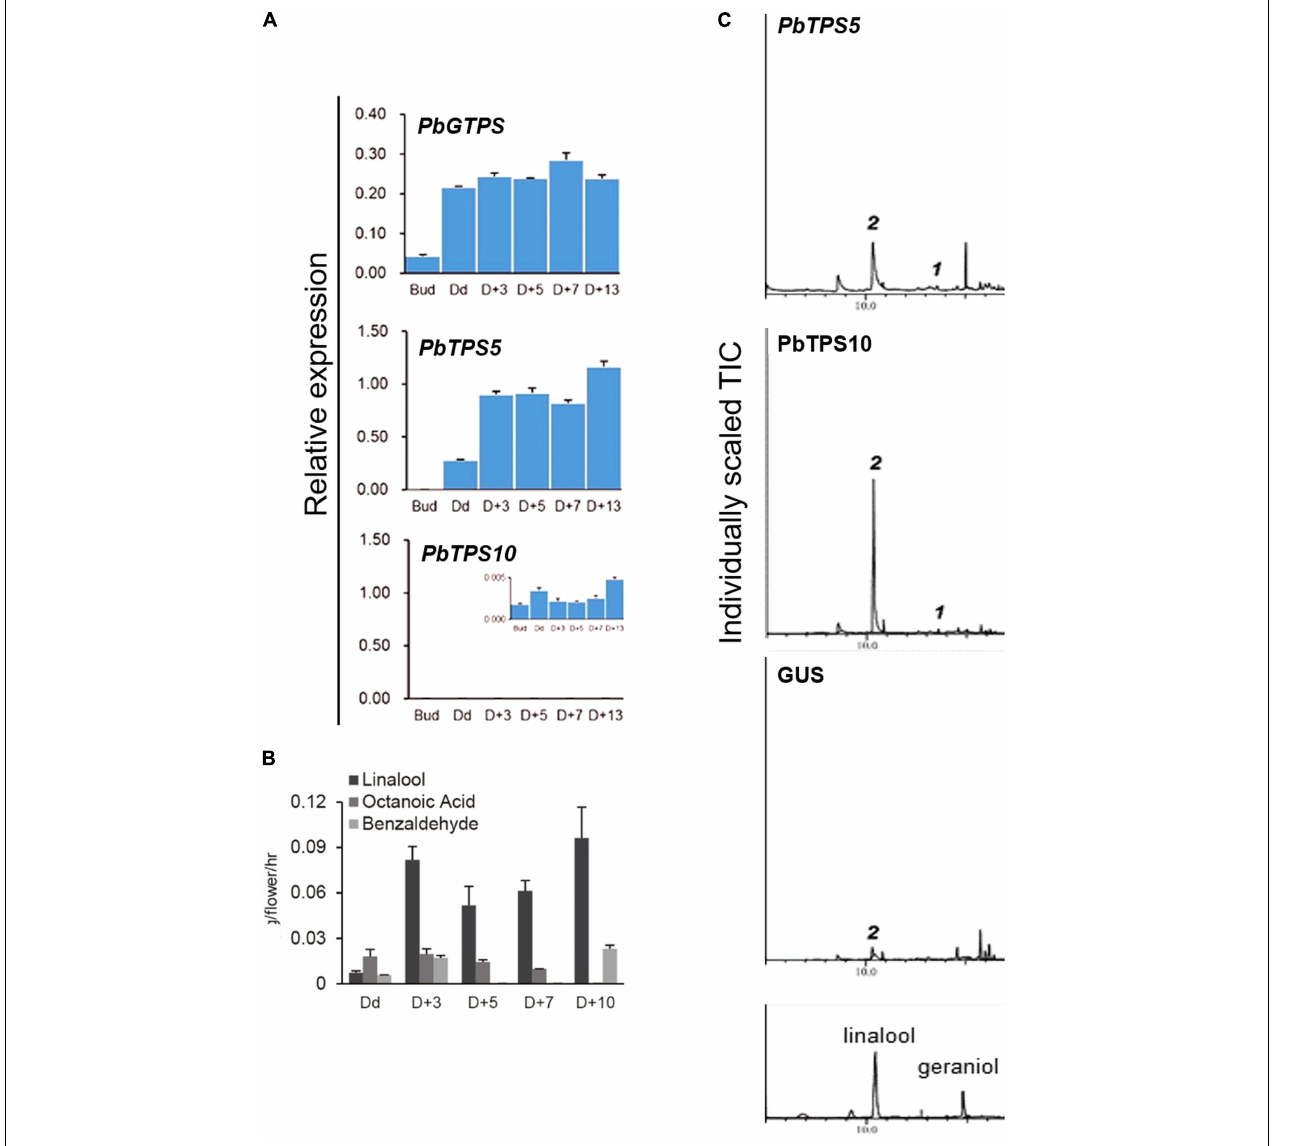
FIGURE 4 | (A) qRT-PCR analysis of gene expression of PbGDPS , PbTPS5 , and PbTPS10 in flowers. The inset for PbTPS10 is the enlargement of the original scale. (B) Floral volatile organic compounds (VOCs) emitted from P. I-Hsin Venus. (C) Functional characterization of PbTPS5 and PbTPS10 transiently overexpressed in Venus. Plants overexpressing GUS were a negative